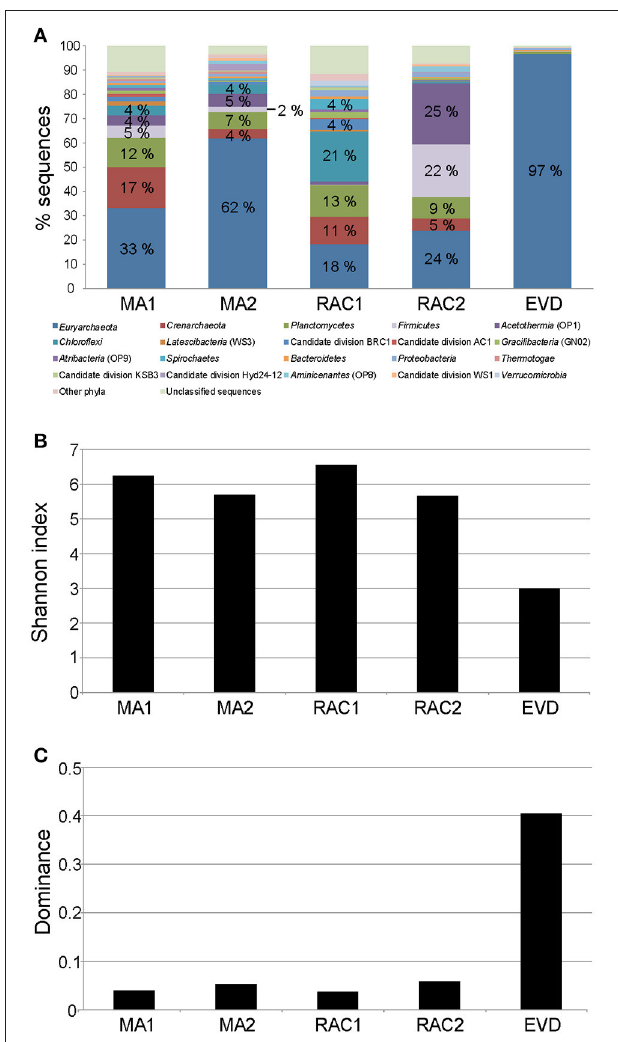
FIGURE 4 | Comparison of the microbial diversity in microbial mats (MA1 and MA2), rhizome-associated lithified concretions (RAC1 and RAC2) and endoevaporite (EVD). (A) Stacked column graph representing the relative distribution of the dominant phyla in the different samples. Sequences were assigned taxonomically using Greengenes database with a minimum percentage similarity of 97% and a minimum e -value of 10 − 5 . (B) Shannon index of the estimated richness of OTUs. (C) Dominance index of